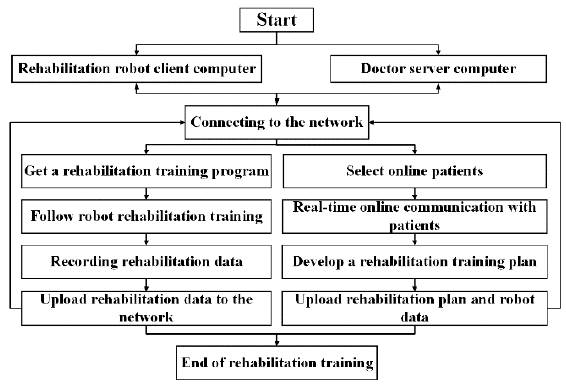
Figure 8. Operation flowchart for the remote system.